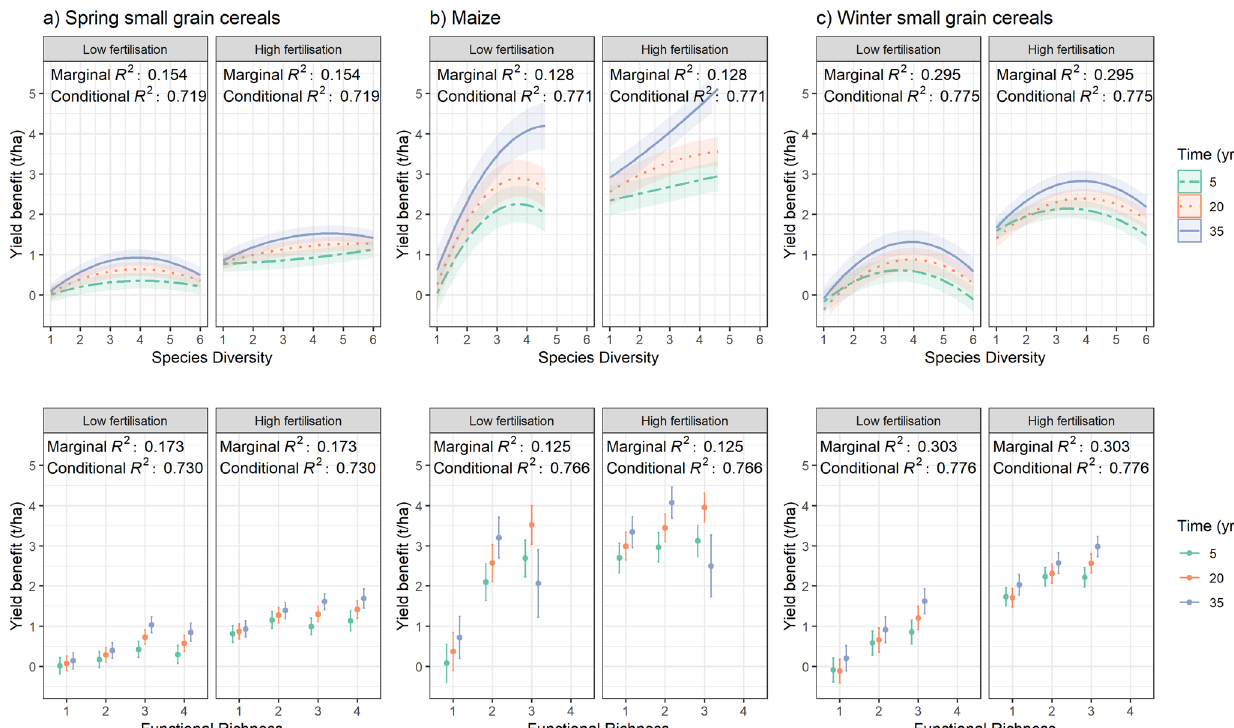
Fig. 2 Yield bene fi t for each indicator crop from crop rotational diversity (CRD) and external nitrogen (N) fertilisation. The y-axis presents model- predicted yield bene fi t compared to monocultures at year = 0, based on mean-centred observations, i.e., the difference from to the long-term within-site average across all CRD treatments for each indicator crop ( a – c ). Yield-bene fi t of 0 indicates model predictions remained the same, negative values are yield losses and positive values are yield bene fi ts as yields in monocultures at year = 0. CRD is characterized by species diversity (based on the inverse Simpson ’ s diversity index; top row) and functional richness (the number of functional groups included in the rotation; bottom row), and external N fertilisation is classi fi ed as low or high (left and right panel in each pair). The curves (top row) and symbols (bottom row) represent model predictions after 5, 20, and 35 years since the beginning of the experiment (dotted green lines, dotted orange lines, and solid blue lines, respectively). We chose these three time periods to represent the early-, middle- and long-term effects of time within our range of data. The 95% CIs are indicated by the shaded areas surrounding the lines (top row) and error bars (bottom